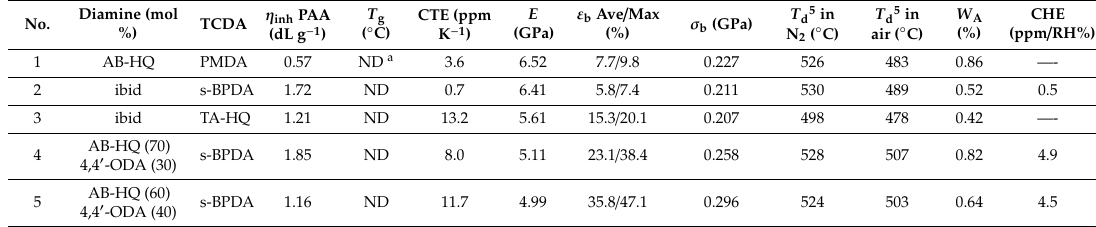
Table 1. Film properties of the PEsIs derived from AB-HQ and common tetracarboxylic dianhydrides (TCDA) and related